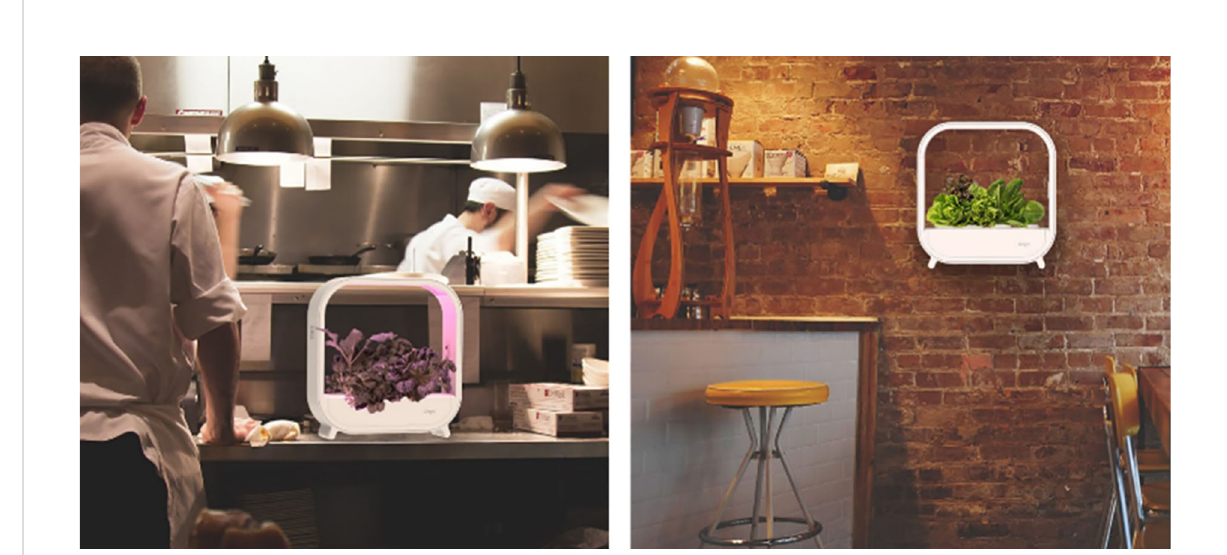
FIGURE 1 Concept design for the two modes of operation: standing (left), and wall-mounted